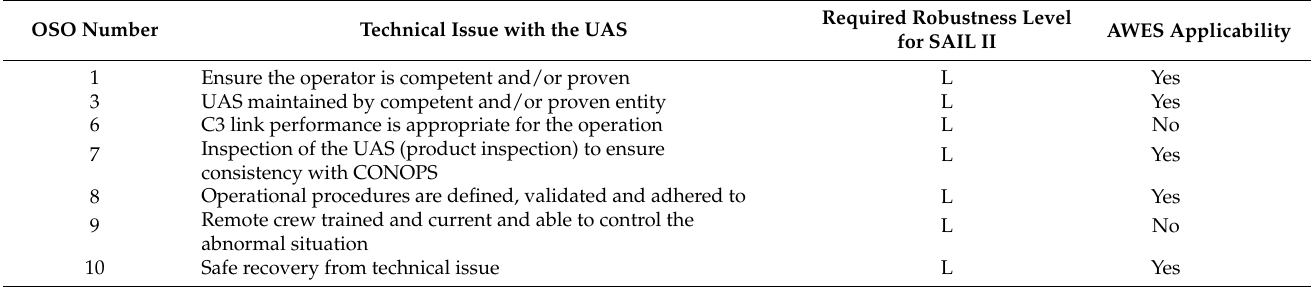
Table 10. Recommended operational safety objectives (OSO) in the SORA and their applicability to commercial AWES, compiled from